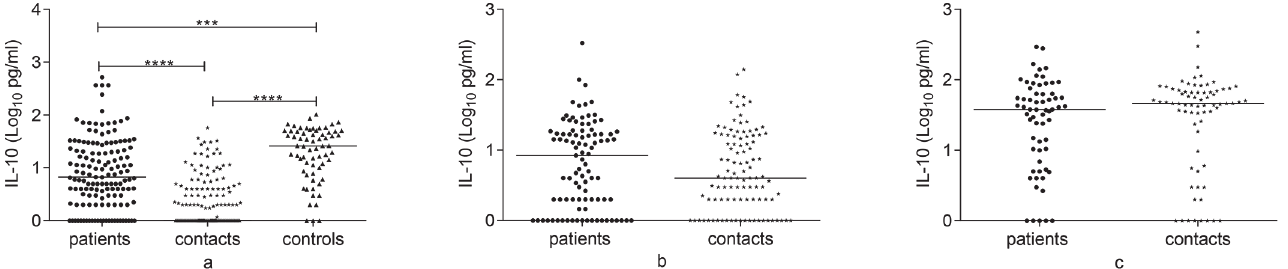
Fig 5. Comparison of IL-10 response to Rv2031 among groups at baseline, 6 and 12 months. IL-10 response at baseline (a), 6 months (b) and 12 months (c) following whole blood stimulation with Rv2031 for 48 hours. Filled circles represent patients, filled diamonds represent contacts and filled triangles represent controls. Results are individual responses and cytokine levels are expressed as log 10 pg/ml. Horizontal bars are medians. Kruskal-Wallis test with Dunn ’ s multiple comparisons (a) and Mann-Whitney test (b and c) were used to compare groups. *** p < 0.001, **** p < 0.0001.